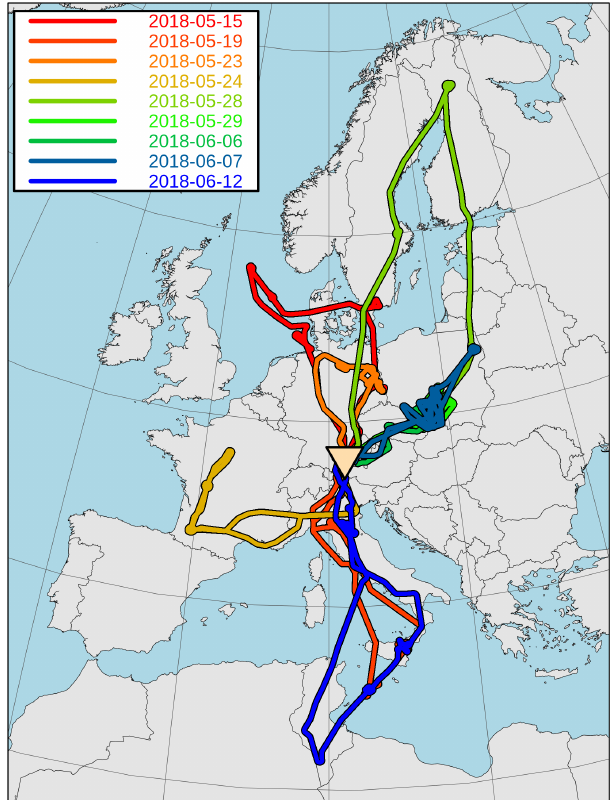
Figure 1. Geographical extent of HALO research flights during the CoMet 1.0